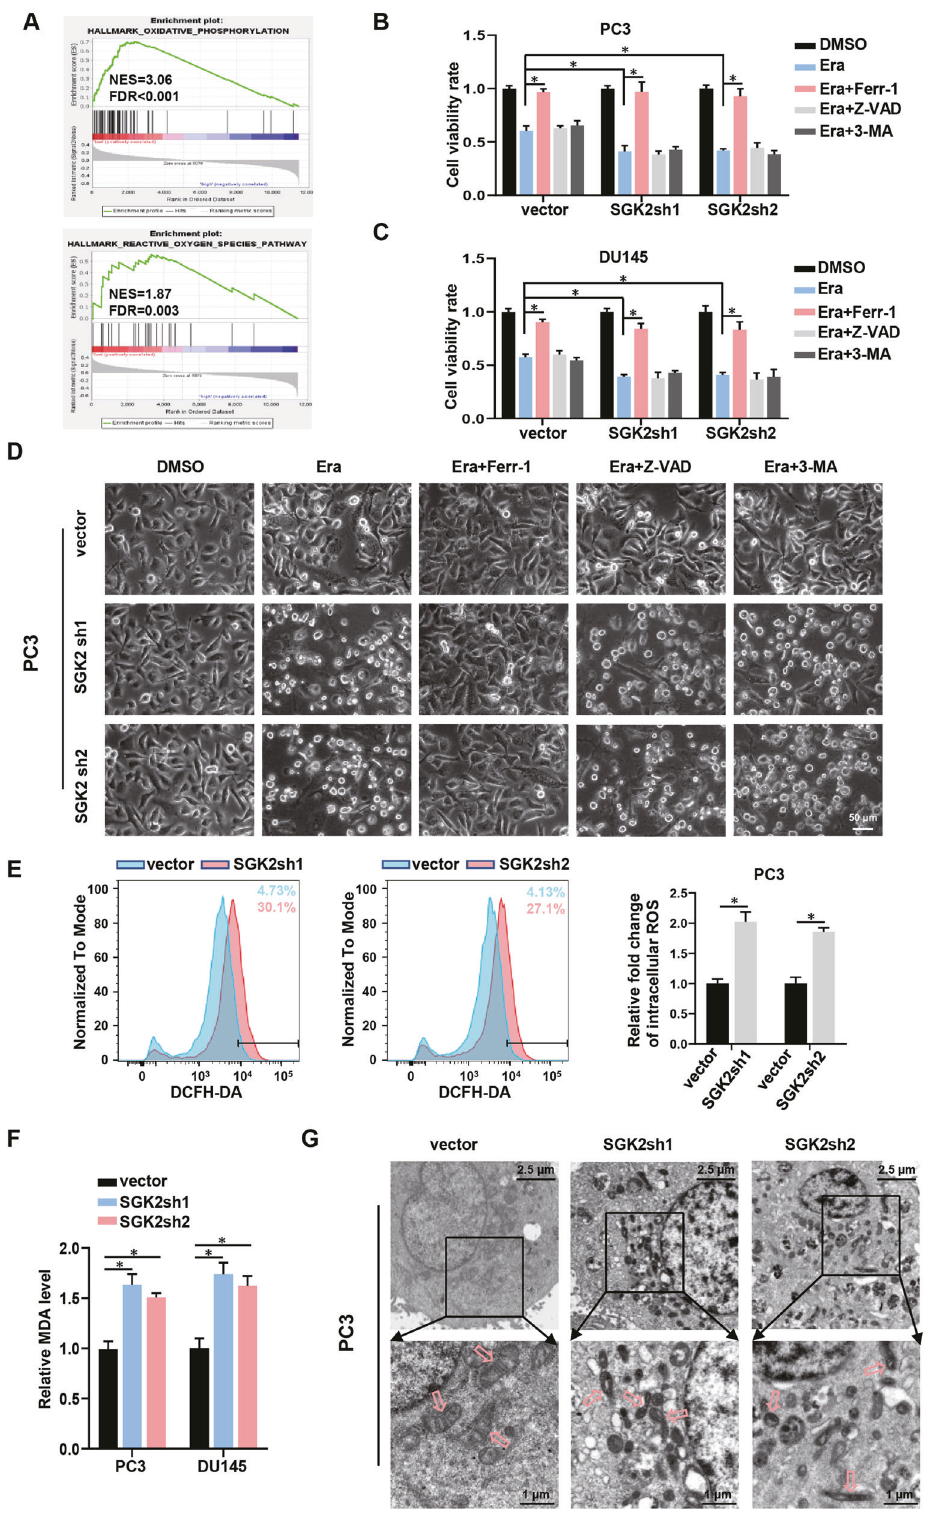
were signi fi cantly elevated by SGK2 downregulation in PCa cells. (Fig. 2E, F; Supplementary Fig. S4B). In addition, the opposite effect was observed in PCa cells stably overexpressing SGK2 (Supple- mentary Fig. S4C – F). Consistent with these results, the morpho- logical characteristics of typical ferroptosis were observed